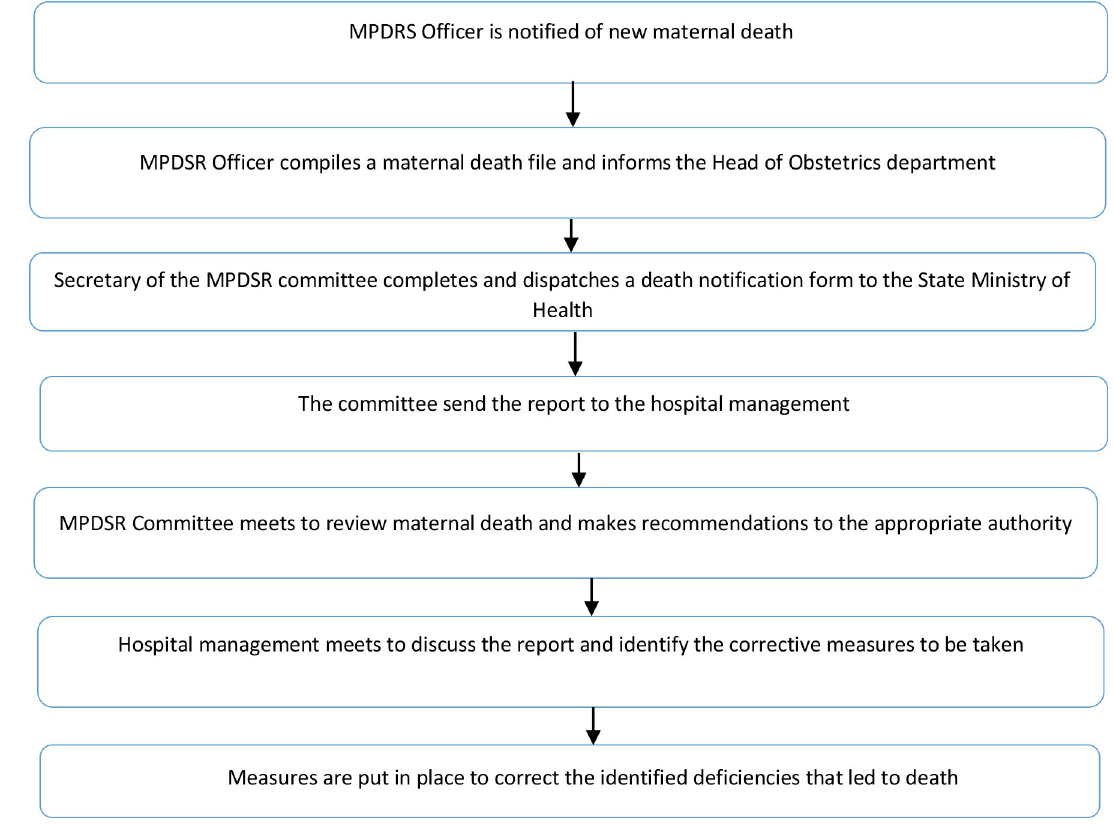
Fig 1. A flow chart showing the MPDSR process used in the